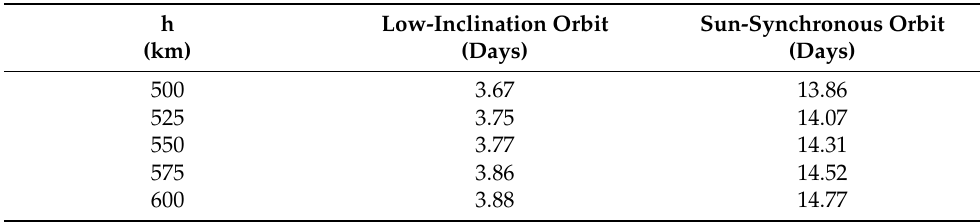
Table 2. Comparison between number of days needed to violate a d min = 10 m threshold for different